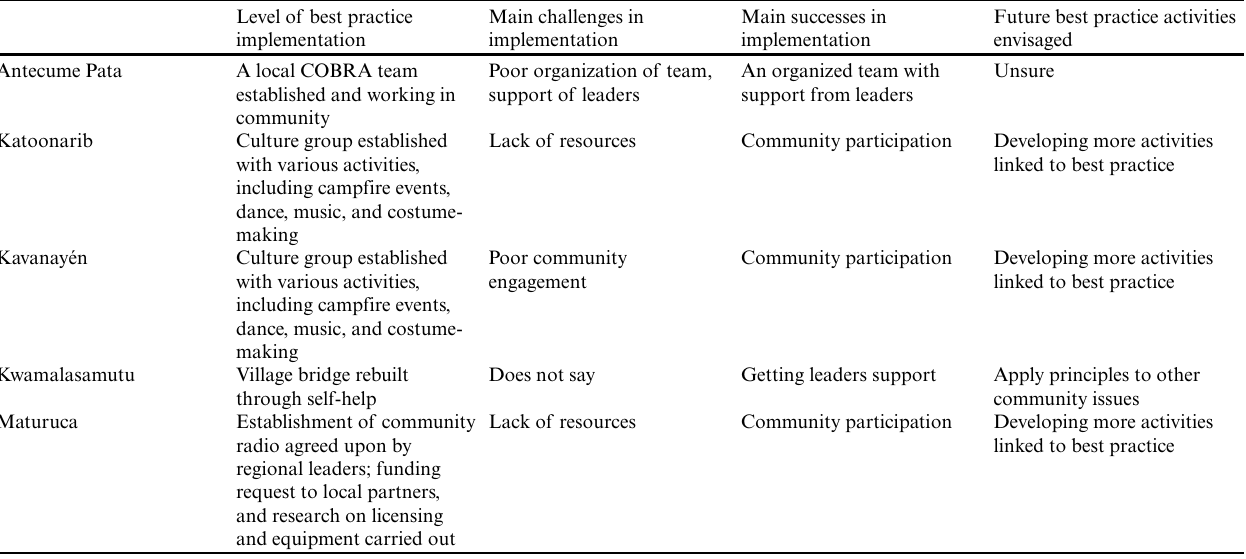
Table 5 . Summary of best practice transfer impact perceived by COBRA